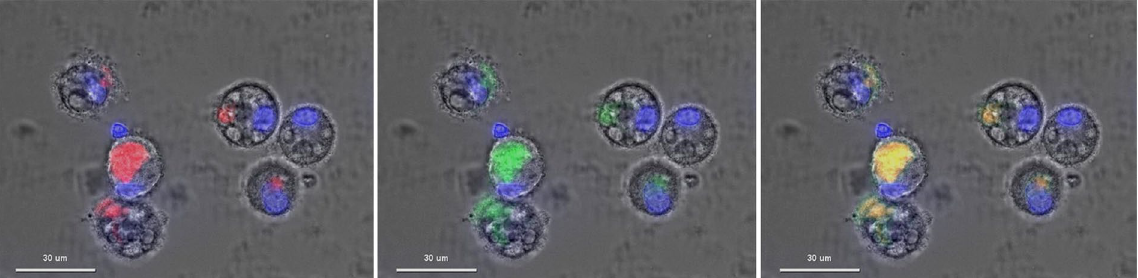
Figure 1. Example of fluorescence microscopy showing lumogallion signal in red (left panel), lysotracker signal in green (central panel), and merged signals (right panel) into differentiated PBMCs exposed 4 h with lumogallion-stained-AH. Scale bars : 30 µm.